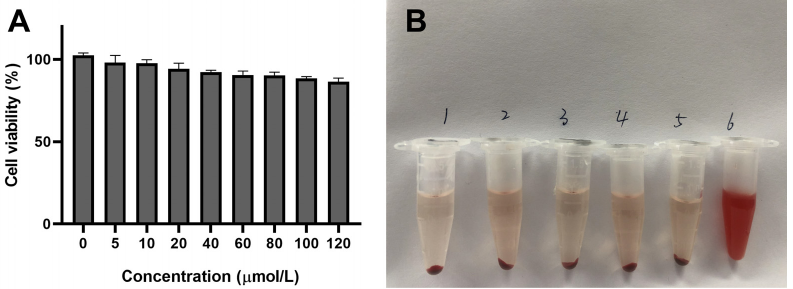
Figure 6. ( A ) In vitro cytotoxicity assay of blank-NLC after 24 h of co-incubation in A549 cells. ( B ) Photo of RBCs mixed with (1) physiological saline, (2) blank-NLC, (3) KA-NLC, (4) HA 20 -KA-NLC, (5) HA 130 -KA-NLC, and (6) ultrapure water for 3 h.